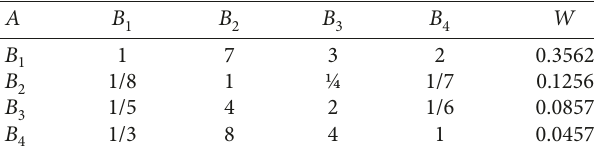
Table 4: Judgment matrix B